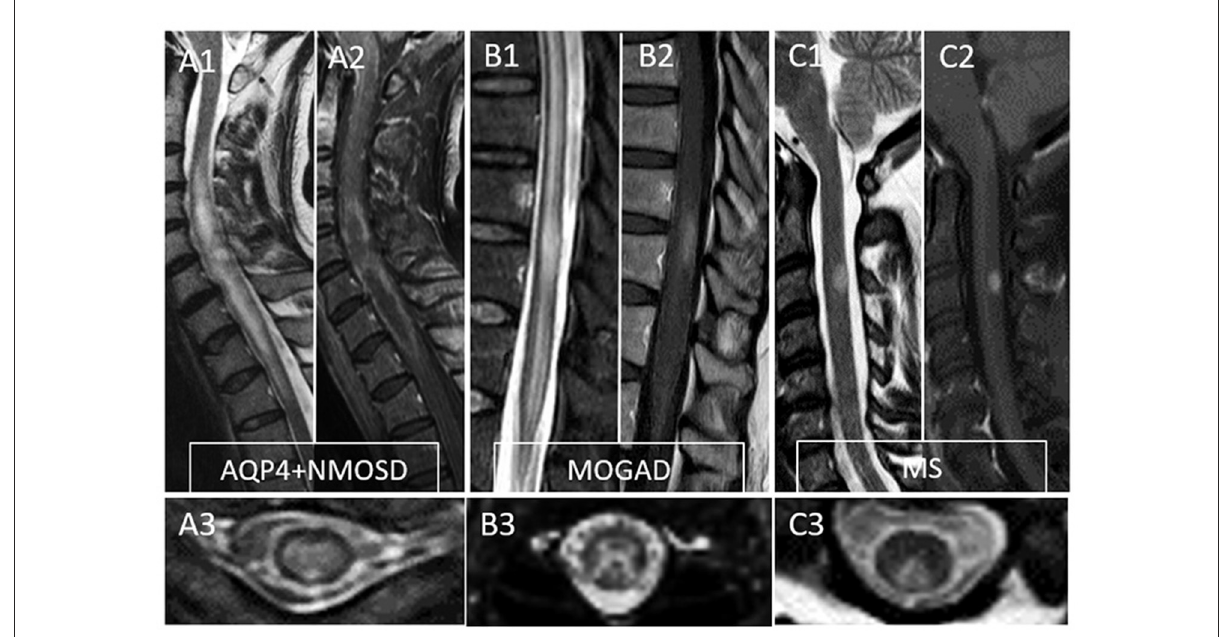
FIGURE2 Typical MRI findings in patients with myelitis associated with AQP4-IgG-positive neuromyelitis optica spectrum disorder (AQP4 + NMOSD), MOG-IgG associated disease (MOGAD), and multiple sclerosis (MS). A typical longitudinally extensive T2-lesion affecting the cervical spinal cord in a patient with AQP4 + NMOSD is evident on sagittal images (A1) , with peripheral enhancement after gadolinium administration—“elongated ring” enhancement (A2) . Axially, the T2 lesion involves the majority of the spinal cord (A3) . In patients with MOGAD myelitis, involvement of the conus medullaris by the longitudinally extensive T2 lesions (B1) is significantly more common compared to NMOSD, with accompanying patchy or nonspecific enhancement in about half of cases (B2) . On axial T2 images, a predominant involvement of the central gray matter is common forming a H-sign (B3) . Lastly, MS myelitis T2 lesions are typically short on sagittal images (C1) and peripherally located along the dorsal (C3) or lateral columns axially. After gadolinium administration, lesion enhancement can be nodular (C2) or